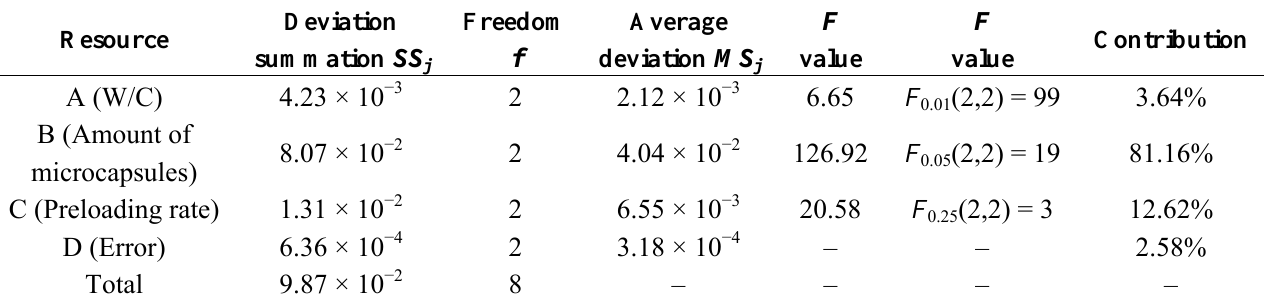
Table 3. Analysis of variance for flexural strength tests.